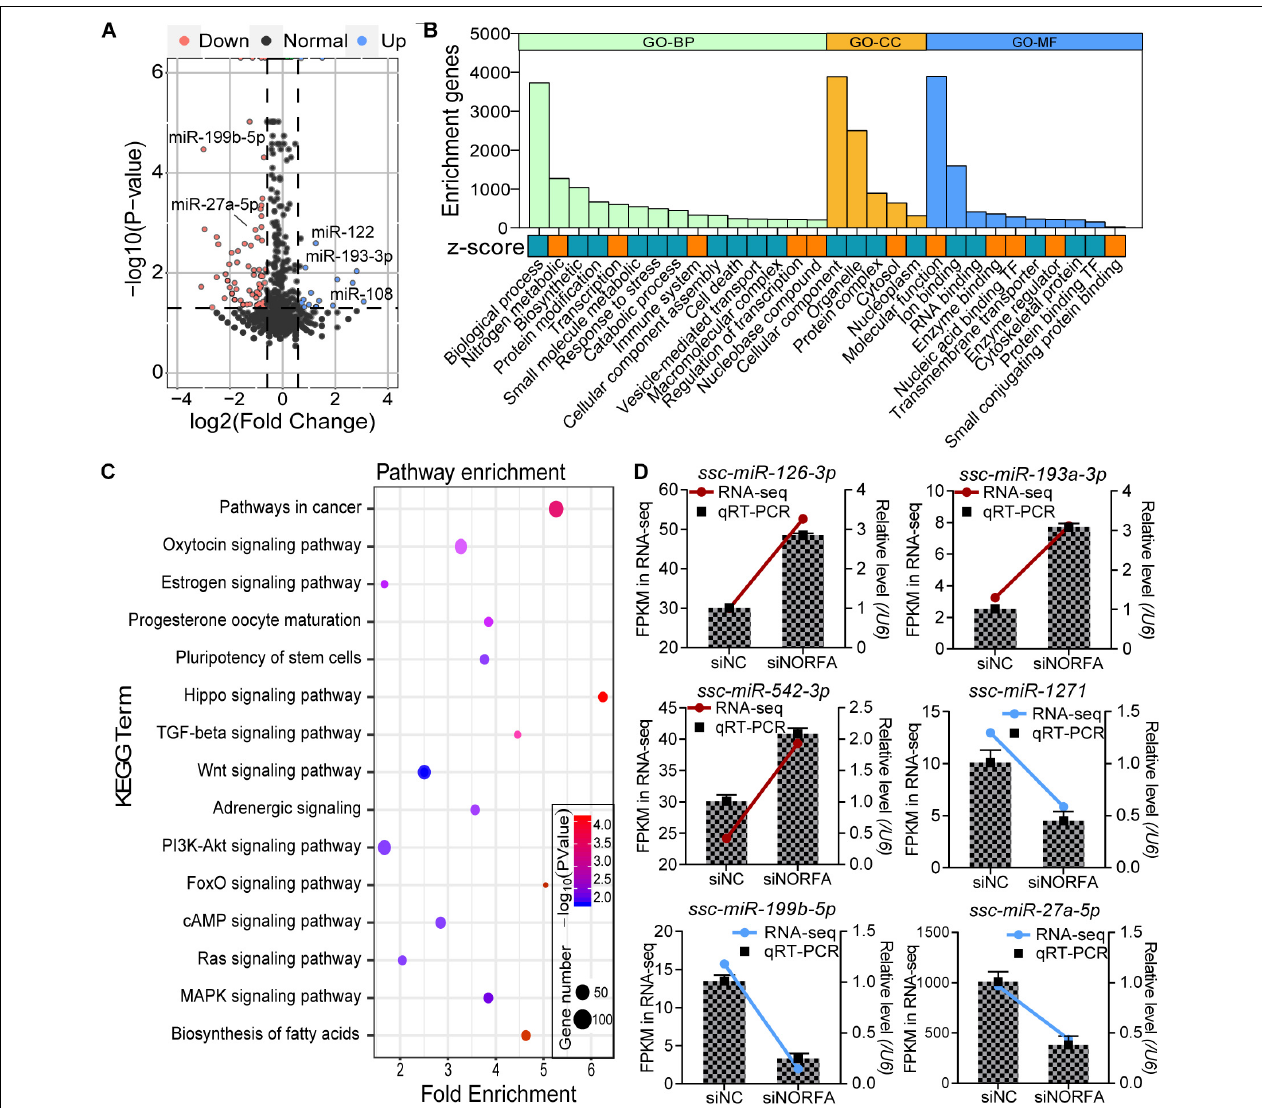
FIGURE 5 | Identification and functional annotation of DEmiRNAs in porcine GCs treated with NORFA -siRNA. (A) Volcano plot showing the expression profile of DEmiRNAs in NORFA -reduced porcine GCs with the following criteria FDR < 0.05 and |Log 2 (fold change)| ≥ 0.59. Up- and down-regulated genes are labeled in blue and pink; the black points indicate normal genes. Several important DEmiRNAs were also indicated in the volcano plot. (B) Gene Ontology analyses of DEmiRNAs in porcine GCs treated with NORFA -siRNA. The columns in green, yellow, and blue indicate the enriched terms of BP (biological process), CC (cellular components), and MF (molecular function) categories. The significant GO terms with their full names were listed below and their expression patterns were estimated by z score, which were labeled in orange (up-regulated) and blue (down-regulated). (C) KEGG pathway enrichment analyses of DEmiRNAs in NORFA -inhibited porcine GCs and significant KEGG terms were also presented. (D) Six DEmiRNAs (three up- and three down-regulated) that are crucial for ovarian GCs were selected, and their expression patterns in porcine GCs were validated by qRT-PCR. The color lines depict the expression patterns of DEmiRNAs determined by RNA-seq, which refers to the left y -axis (red and blue indicate up- and down-regulated). The bars represent the results of qRT-PCR by referring to the right y -axis (mean ± S.E.M.; n = 3).